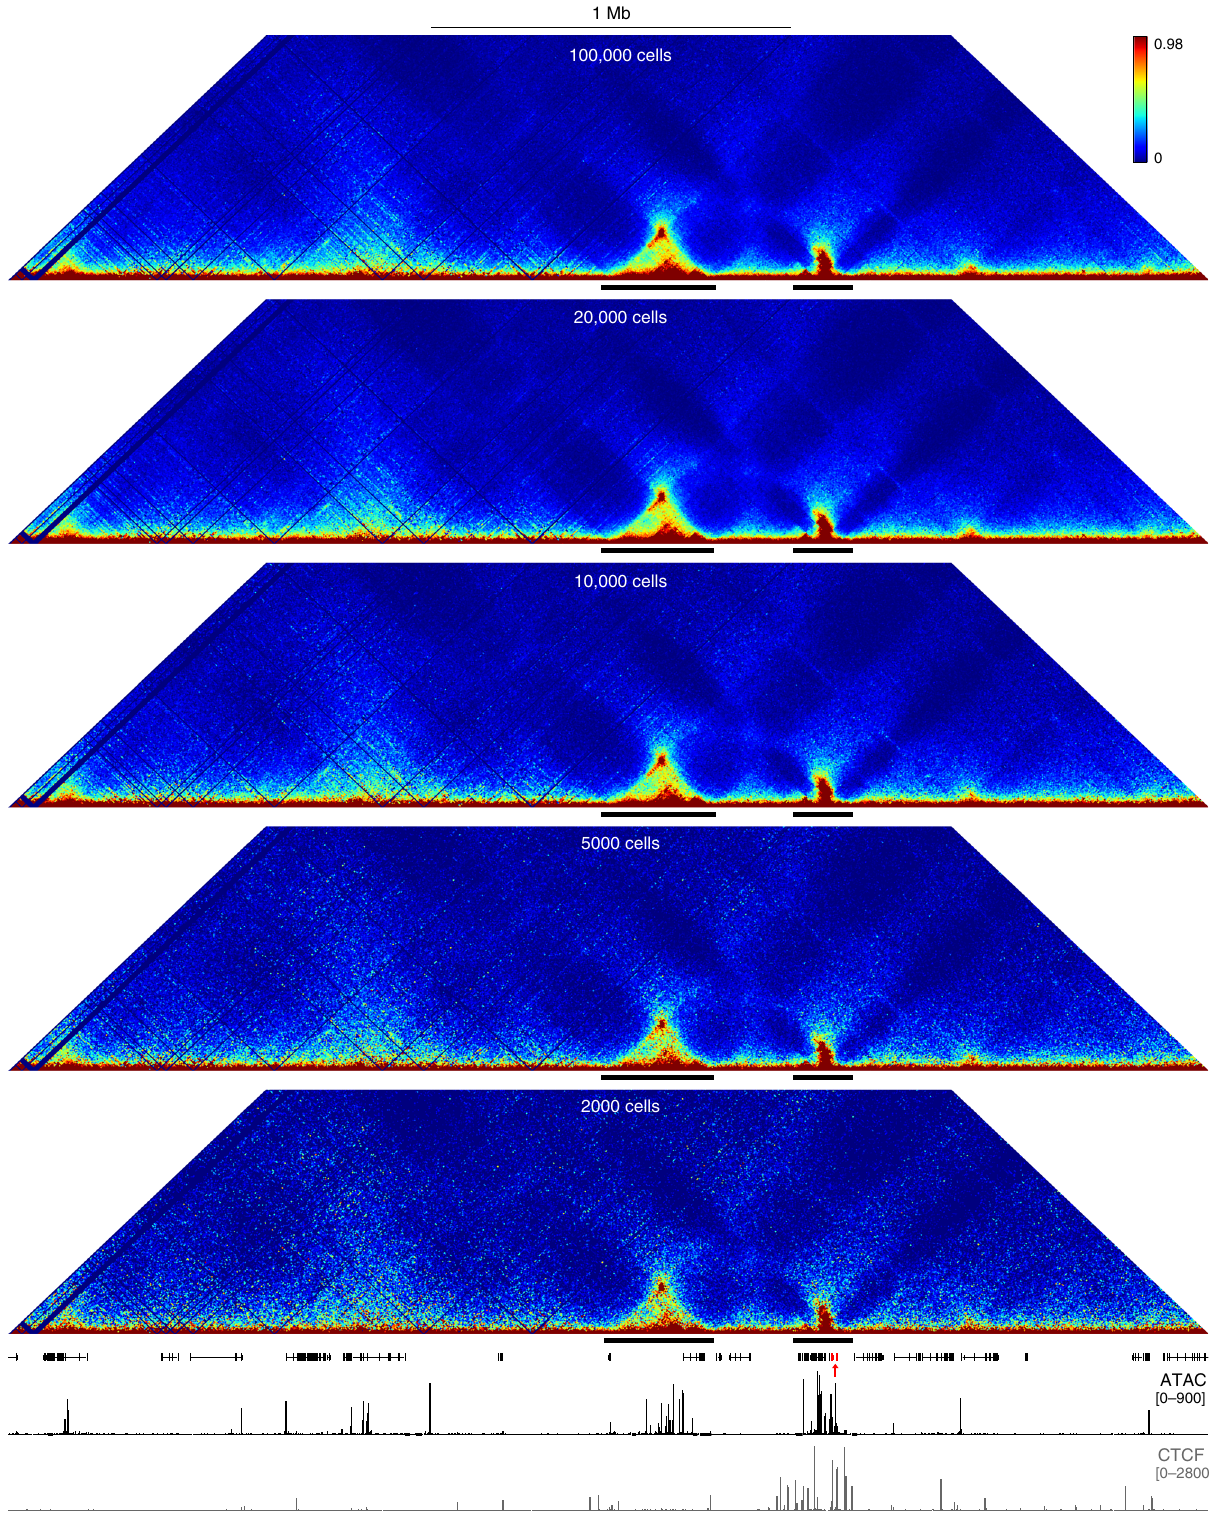
Fig. 2 Tiled-C generates high-resolution contact matrices from small numbers of cells. Tiled-C contact matrices of ~3.3 Mb spanning the mouse α -globin locus at 5 kb resolution, generated from small aliquots of primary mature erythroid cells. Contact frequencies represent normalized, unique interactions in three replicates. TADs are indicated below each matrix with a black bar. Gene annotation ( α -globin genes highlighted in red), open chromatin (ATAC), and CTCF occupancy are shown below the matrices. Coordinates (mm9): chr11:29,900,000 –